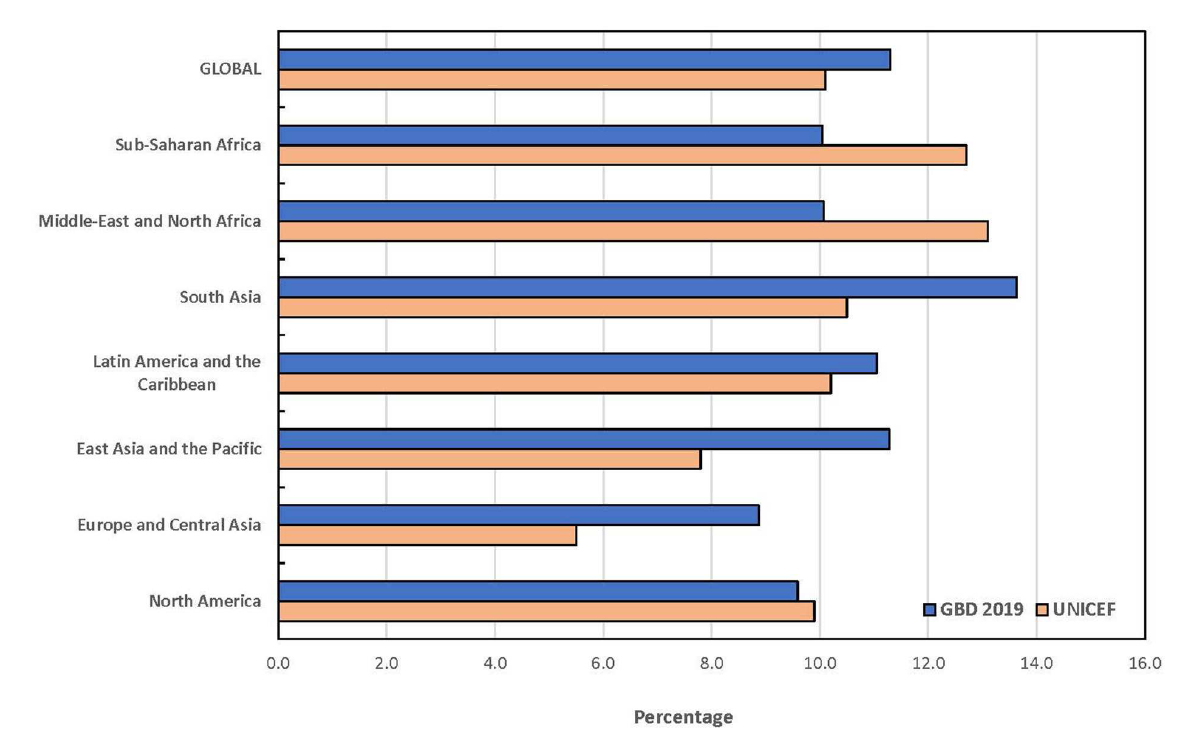
FIGURE3 Prevalence estimates of disabilities among children under 20 years by UNICEF and GBD 2019.